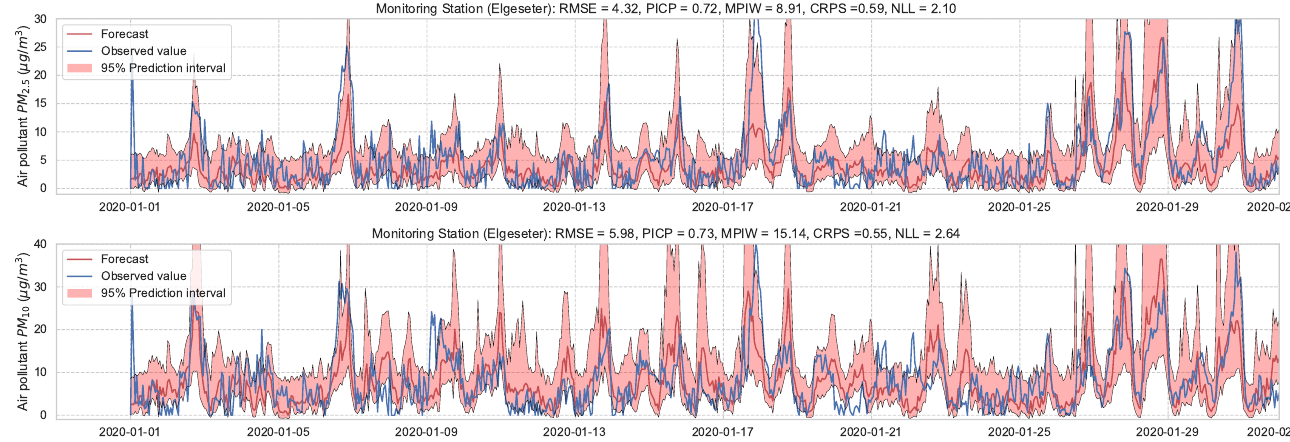
Figure 17. Probabilistic forecasting of multivariate time-series air quality using an LSTM model with MC dropout.